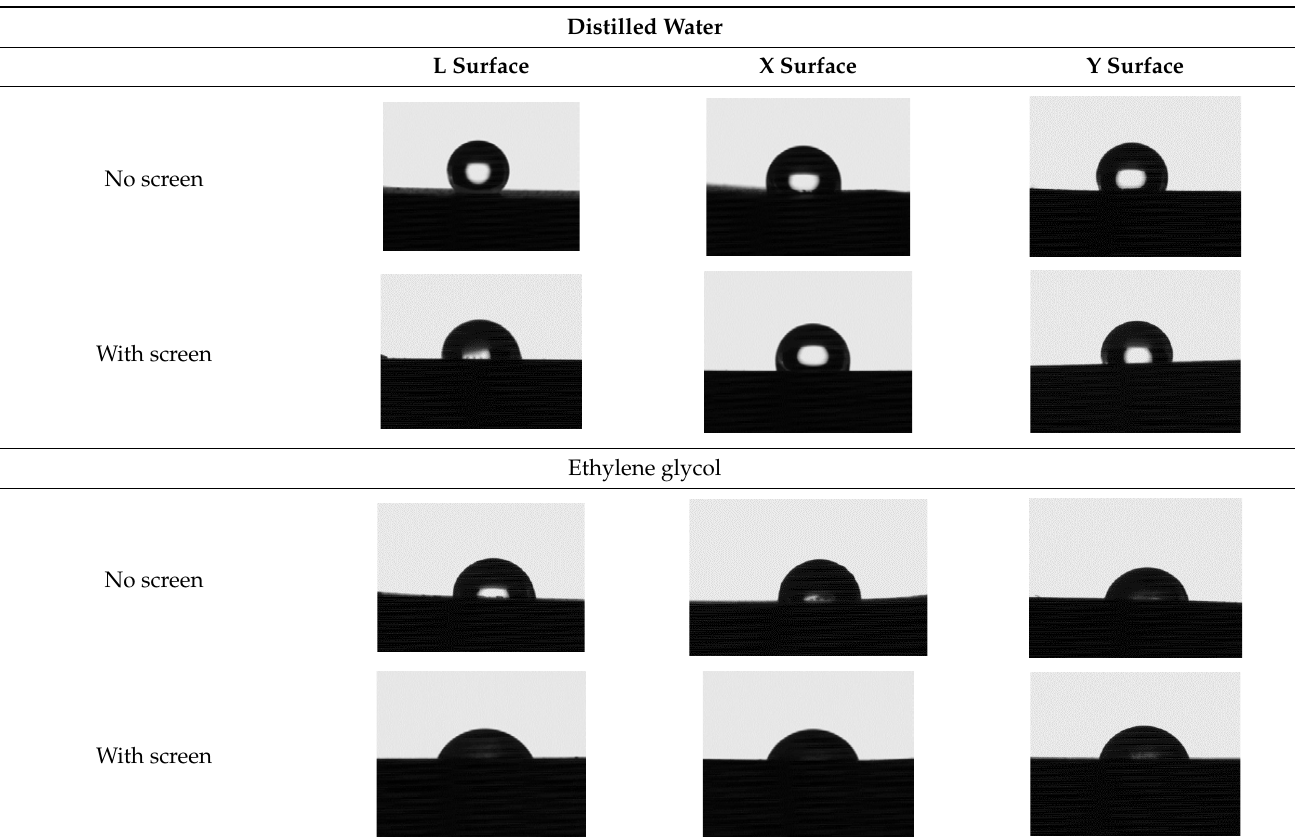
Table 5. Images obtained for contact angle test on nitrided surfaces.